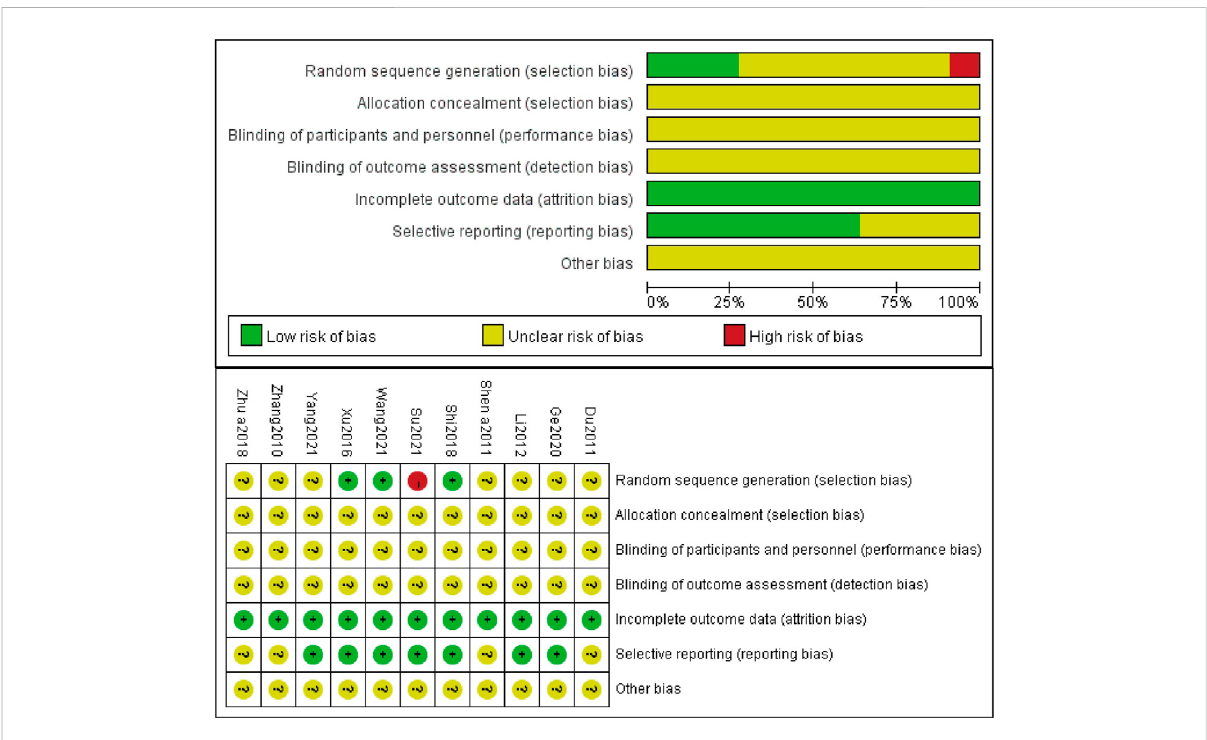
FIGURE 2 Risk of bias graph and risk of bias